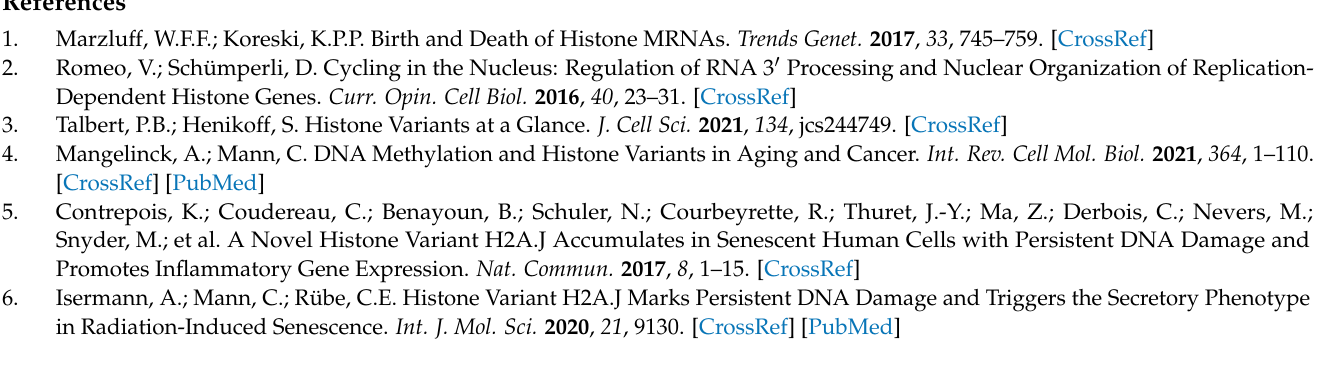
cells as for the KLK3 prostate-specific antigen gene. Figure S5: H2A.J is expressed at higher average levels in ER-positive breast cancer biopsies compared to ER-negative biopsies. Figure S6: Single-cell RNA-seq analysis of human prostate cancer epithelial cells shows that H2AFJ (A,C) and KLK3 (B,D) are expressed in a similar set of luminal-type epithelial prostate cancer cell clusters as shown in UMAP representations and violin plots. Figure S7: Kaplan-Meier survival curves for breast cancer patients expressing the indicated levels of H2AFJ RNAs. Figure S8: Kaplan-Meier survival curves for the indicated TCGA cancer types as a function of H2AFJ RNA expression. Figure S9: Absence of H2A.J expression in T47D-H2A.J-KO1 and T47D-H2A.J-KO18 cell lines compared to parental T47D cells as determined by Western blotting (A) and immunofluorescence (B) with an anti-H2A.J antibody. Figure S10: T47D, T47D-H2A.J-KO1, and T47D-H2A.J-KO18 cells show similar sensitivity to growth inhibition by 4-hydroxy-tamoxifen. Figure S11: Expression of estrogen-responsive genes is inhibited in H2A.J-KO cell lines relative to parental T47D cells. Figure S12: Heat maps for the gene sets that are significantly enriched relative to genes differentially expressed in H2A.J-KO cells versus parental T47D cells. Table S1: Number of patient samples for each tissue type obtained from the GTEx v.8 database. Table S2: RNA-seq analysis data for T47D and H2A.J-KO